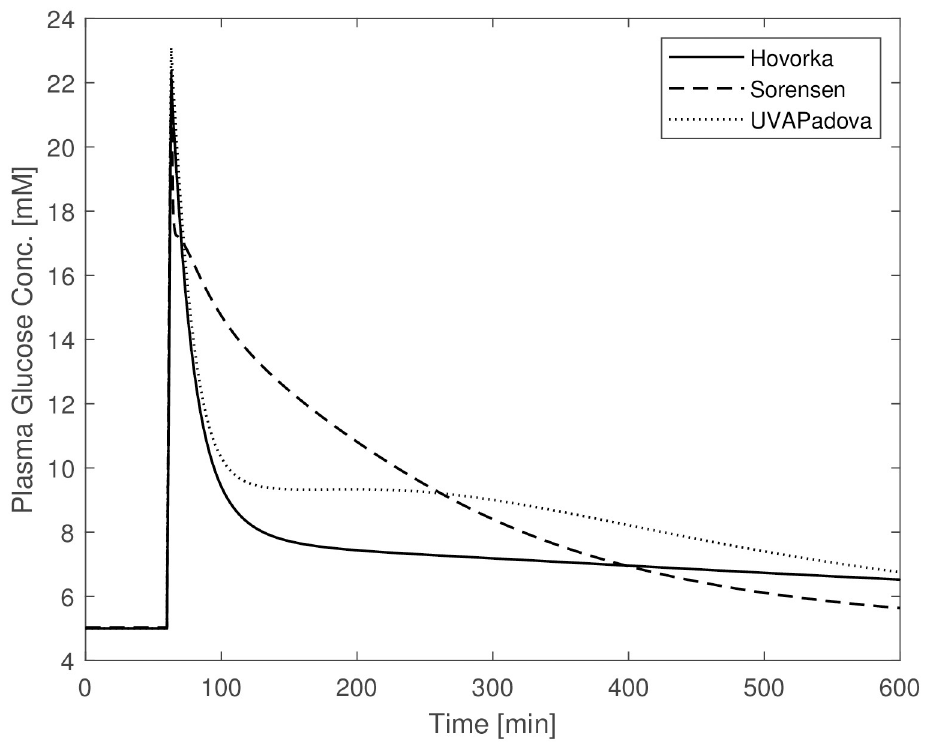
Fig 4. Blood glucose concentrations from the Hovorka (solid line), Sorensen (dashed line) and UVAPadova (dotted line) models, during the in-silico IVGTT experiment in conjunction with an insulin bolus.